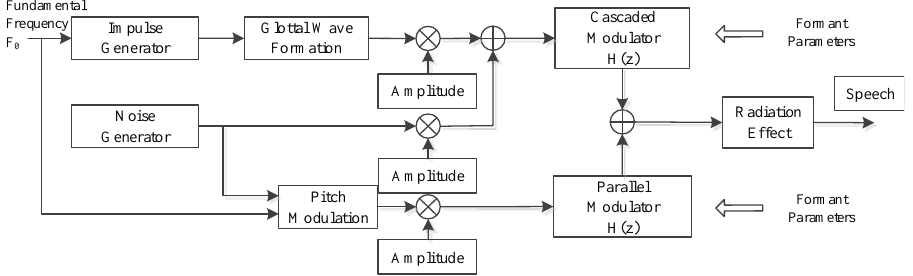
Figure 5. Hybrid formant synthesizer